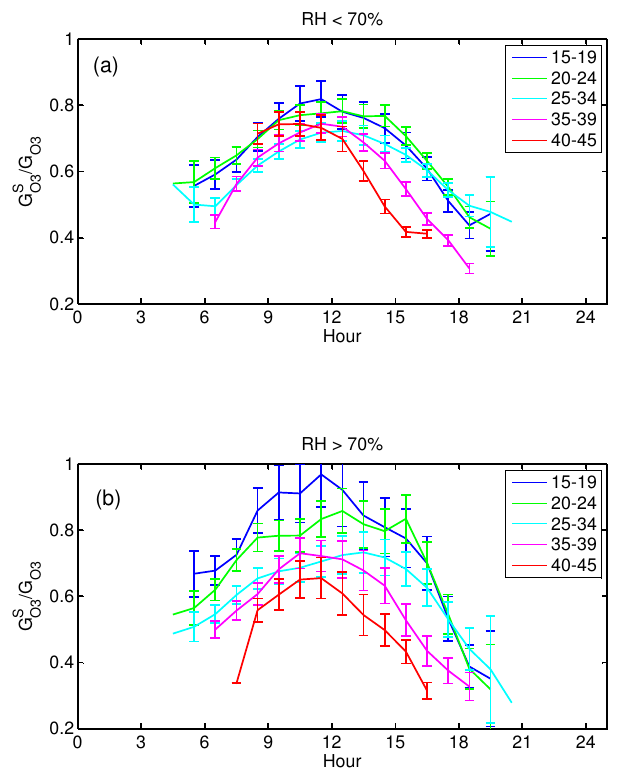
Fig. 4. Diurnal variation of the ratio of the average stomatal and to- tal ozone conductances for RH<70% (a) and RH>70% (b) . Bars denote standard